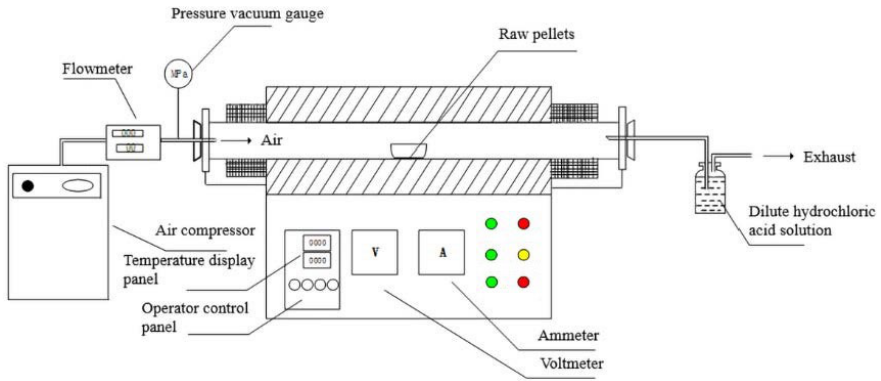
Figure 1. Diagram of experimental device.